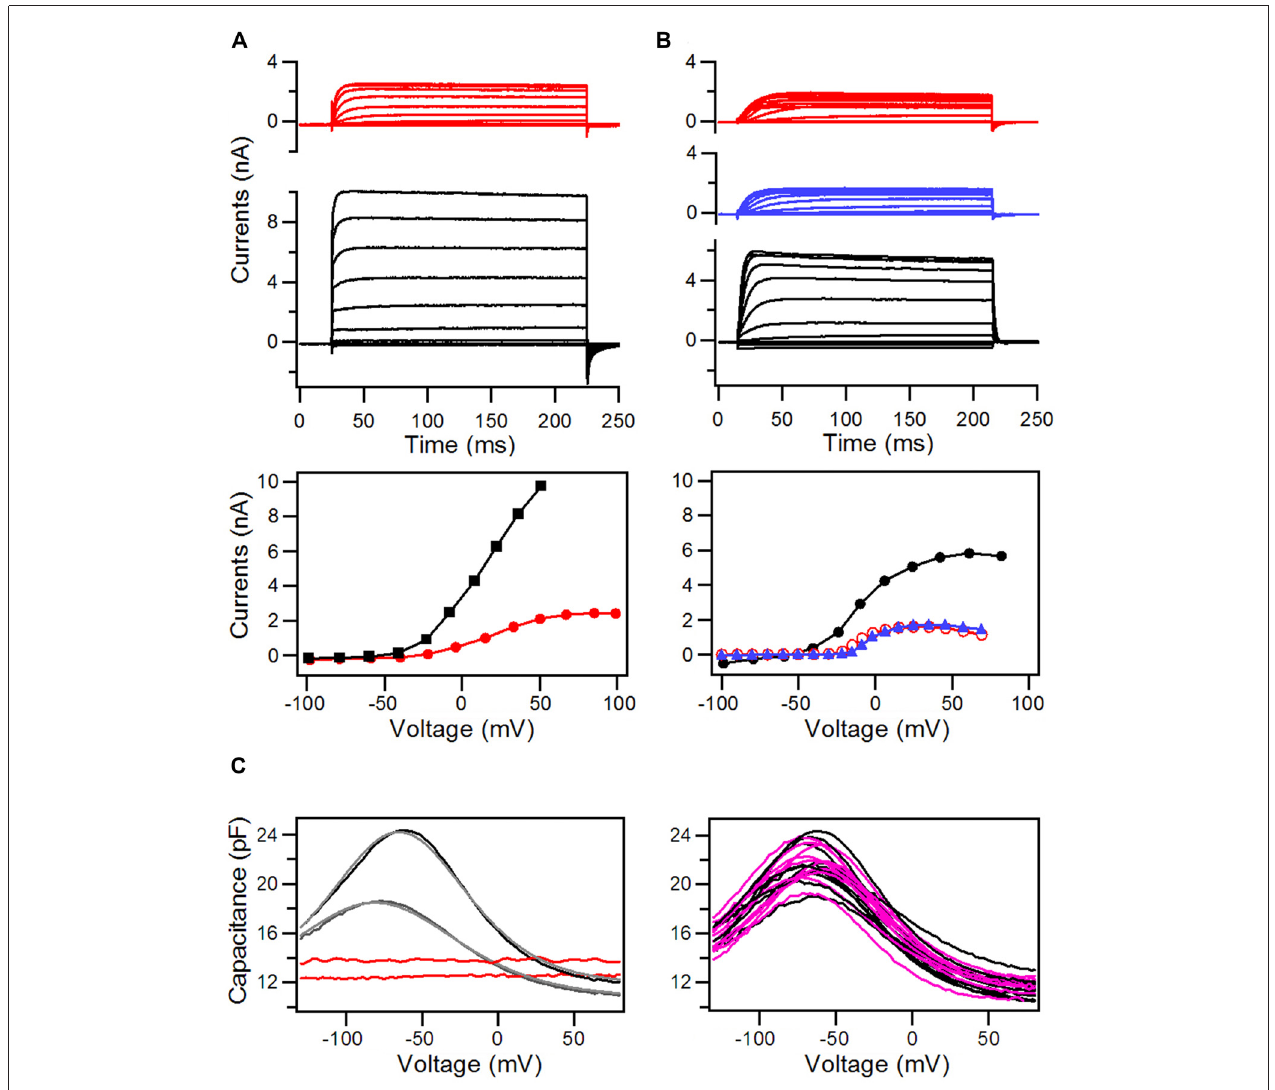
FIGURE 6 | Whole-cell currents and nonlinear capacitance (NLC) recorded from hair cells and HCLCs in the regions of IHCs and OHCs from 8-day-old cultures with DAPT treatment. (A) Whole-cell currents recorded from an HCLC (red) and an IHC (black) in the IHC region. I-V curves from the steady-state response of the whole-cell current are plotted in the middle panel. (B) Whole-cell currents recorded from an HCLC (red) and an OHC (black) in the OHC region. I-V curves are plotted in the middle panel. (C) NLC measured from HCLCs in cultures at 8 and 12 days. NLC from recorded from OHCs in the same preparation was also shown for